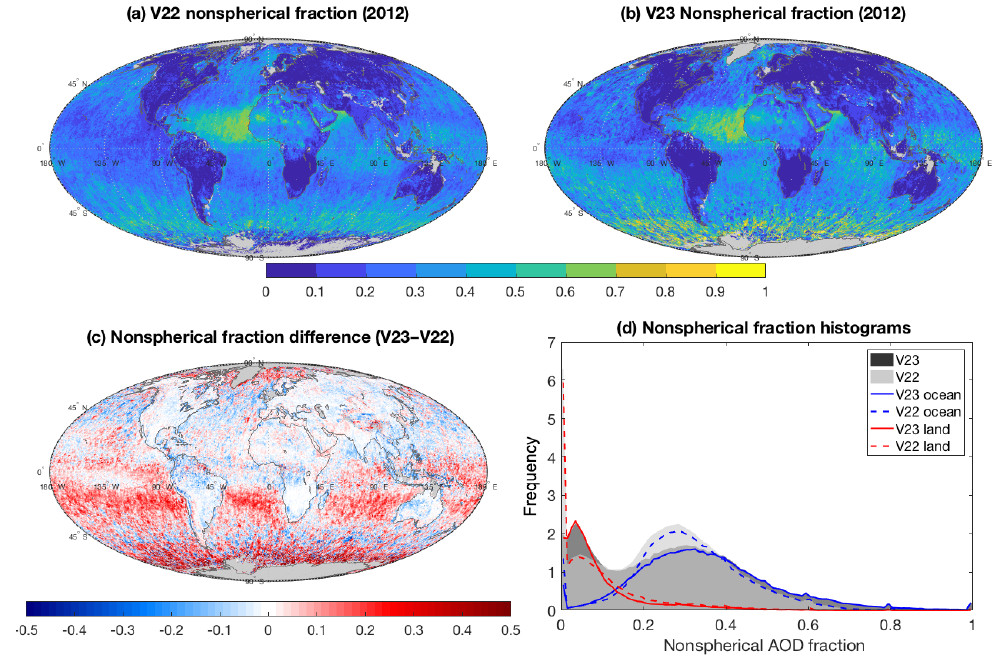
Figure 11. As in Fig. 7 except for the MISR-retrieved AOD fraction of nonspherical aerosol. AOD weighting is applied in nonspherical fraction averaging at each grid